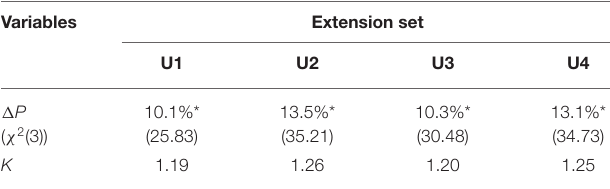
TABLE 5 | 1 P and K of decoy effect in the yellow-feathered broilers experiment. Variables